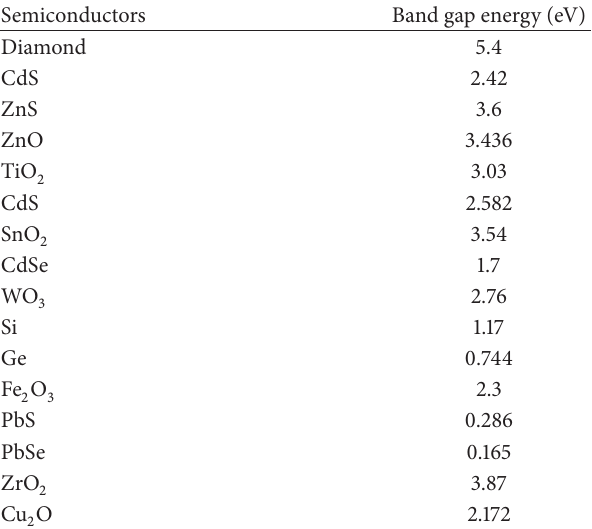
Table 2: Band gap energy for some common semiconductor mat- erials [46].